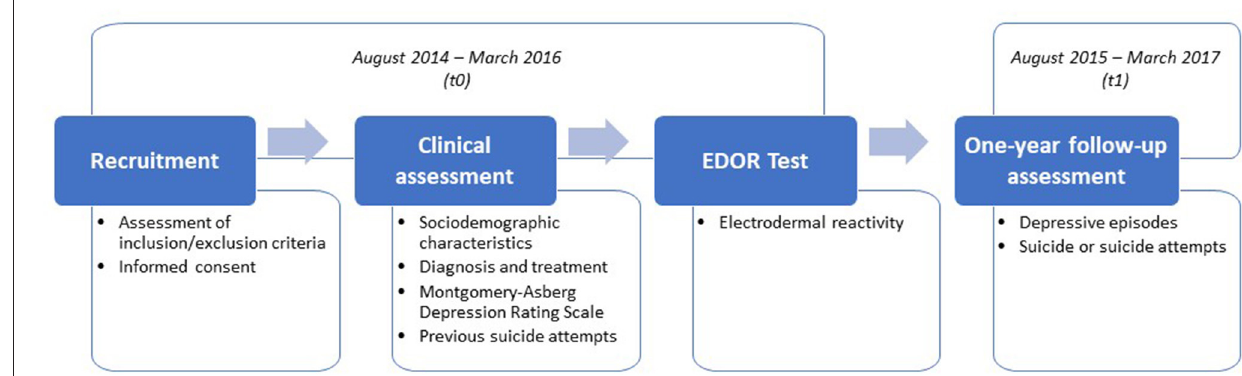
FIGURE 1 | EUDOR-A study design.